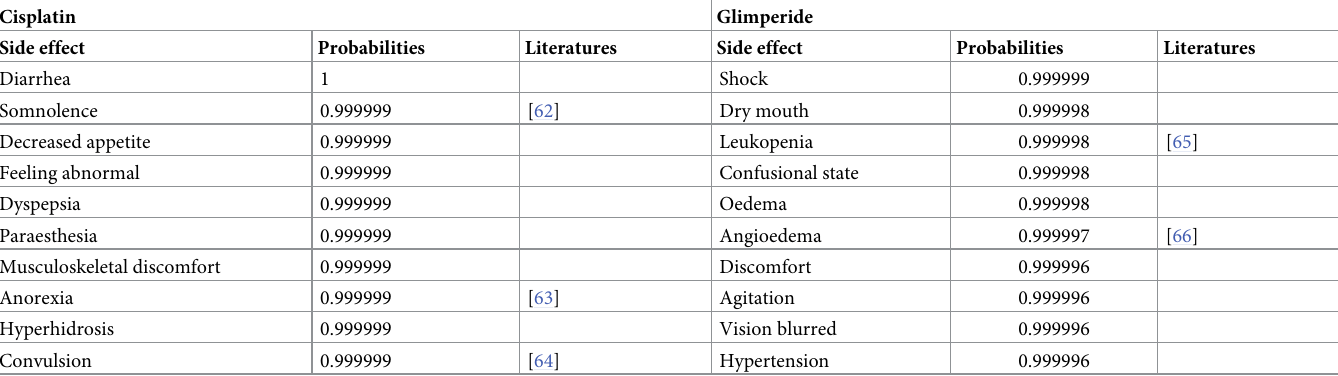
Table 10. New predictions not seen in the dataset SIDER,